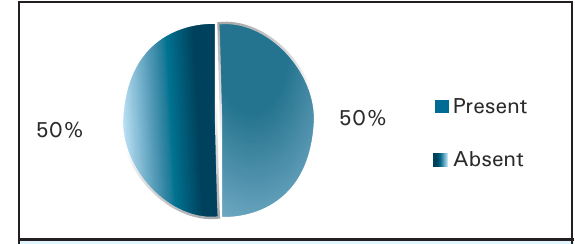
Figure 1. Showing age distribution of retinoblastoma (n=42).